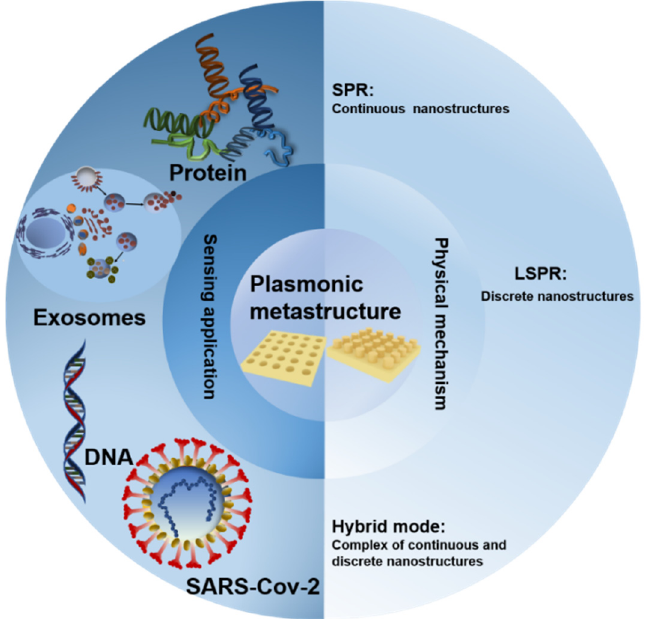
Figure 1. An overview of this review, the center is the typical sensing structure of plasmonic metasurfaces.